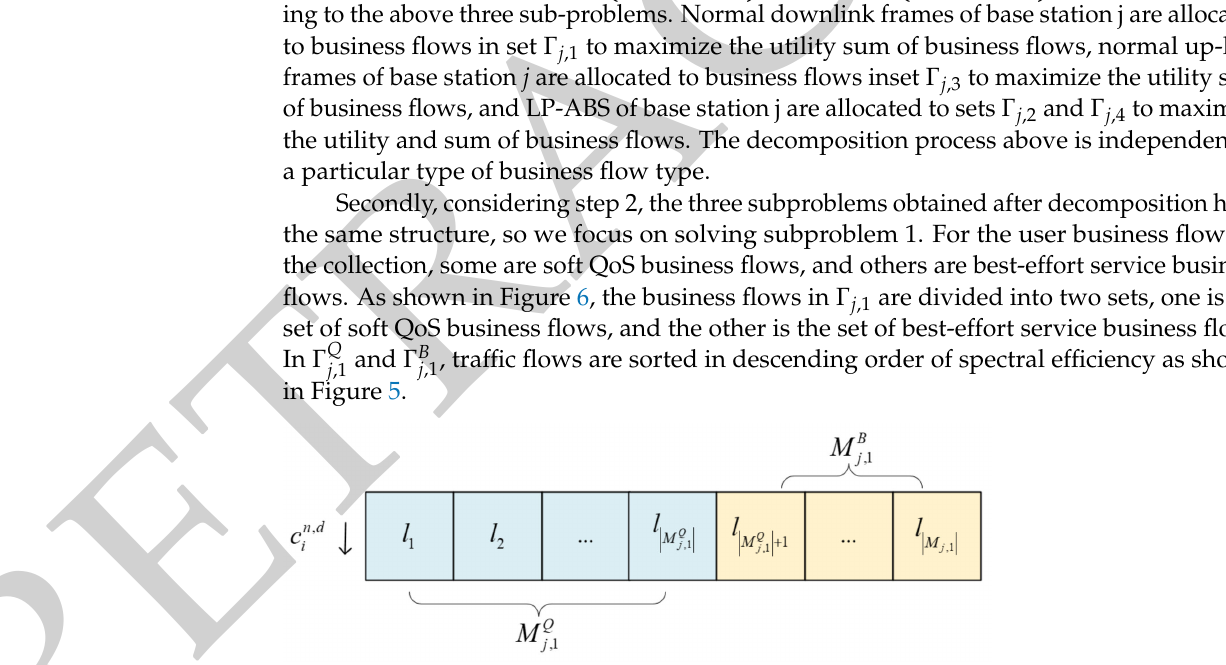
Figure 6. The business flows in Γ j ,1 are classified into business types and sorted in descending order according to c n , d i